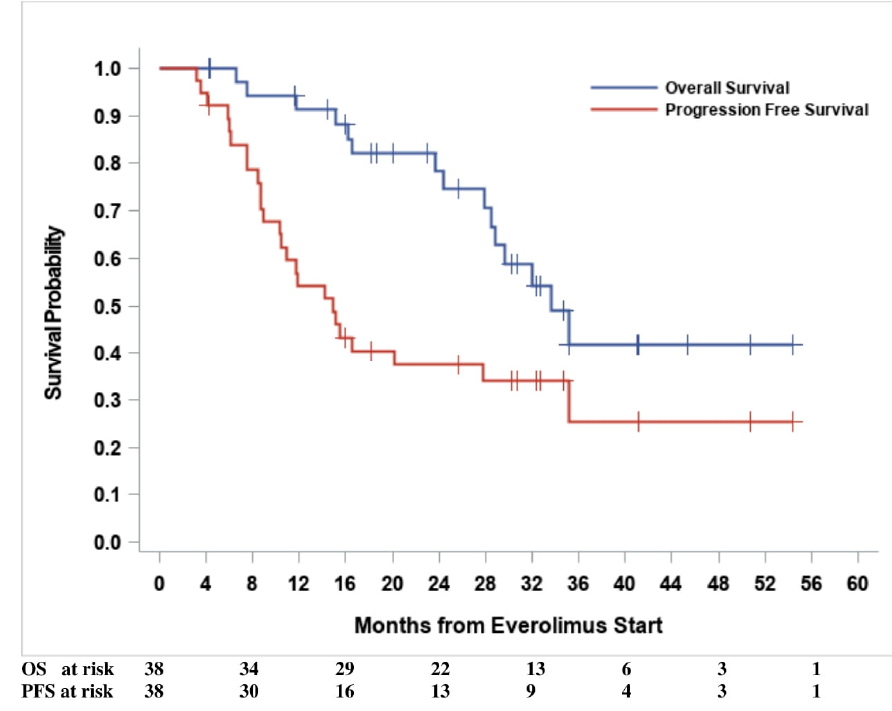
Figure 2. Survival outcomes.